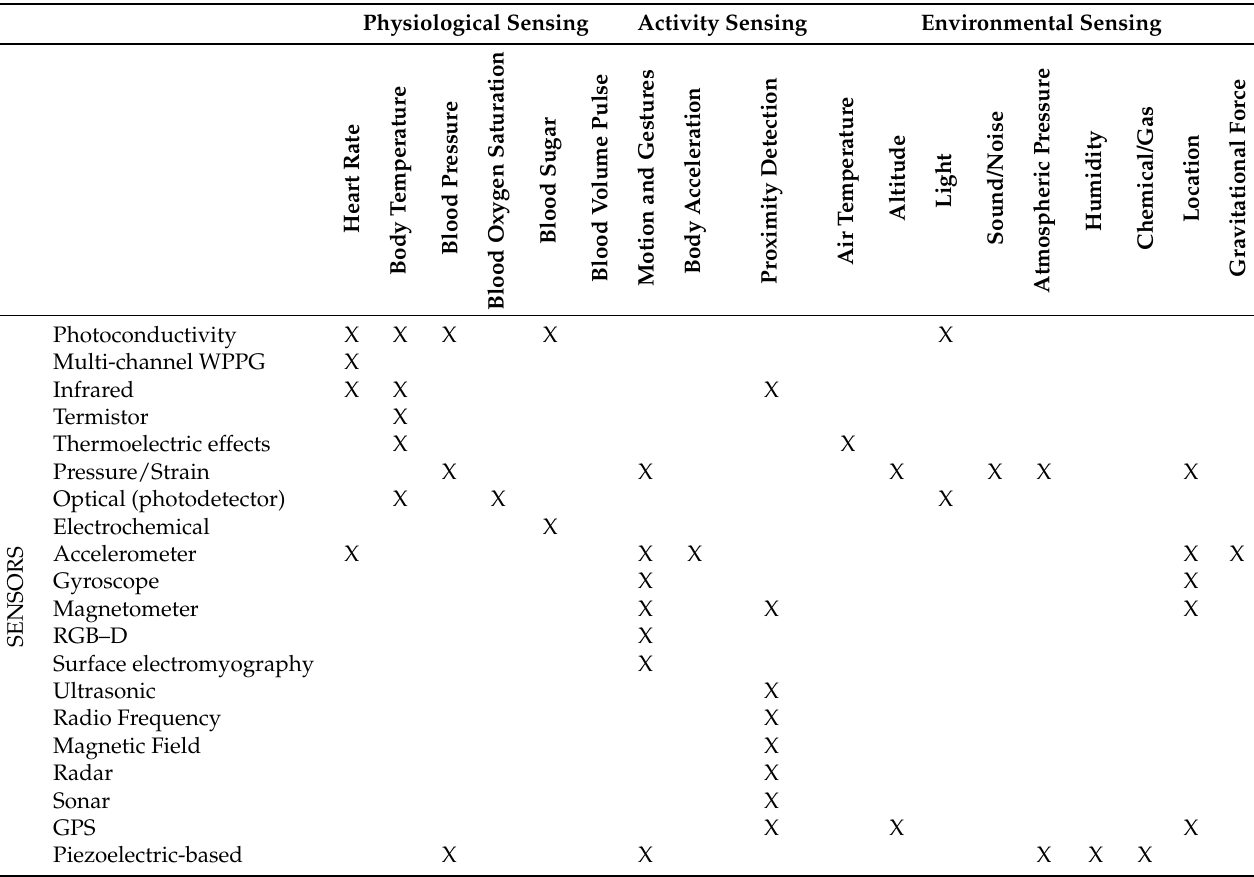
Table 3. The overview of sensors used in physiological, activity and environmental